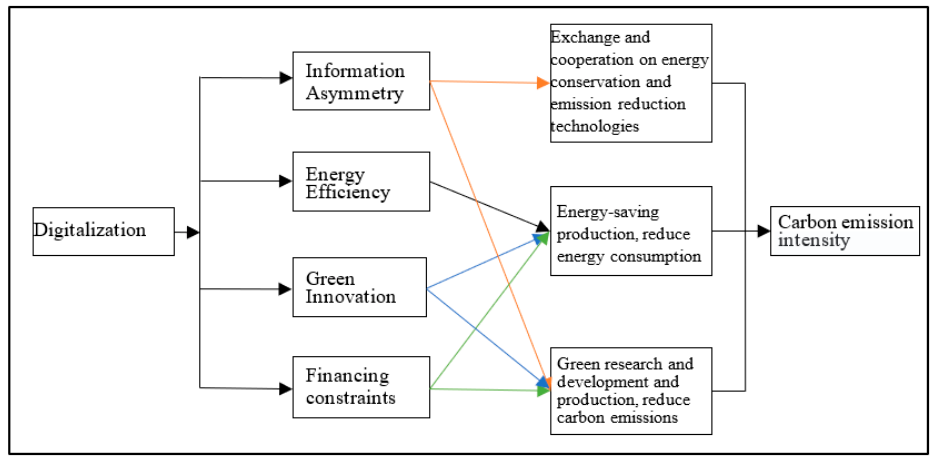
Figure 1. Mechanism diagram of the impact of digitalization on carbon emission intensity.